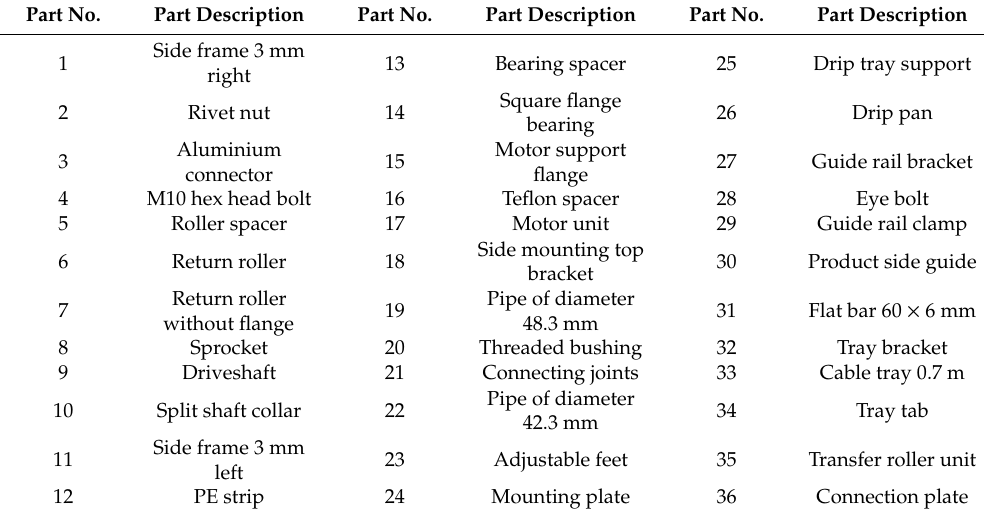
Figure 5. Exploded diagram for ‘front drive straight section’. Table 2. Parts description for ‘front drive straight section’.